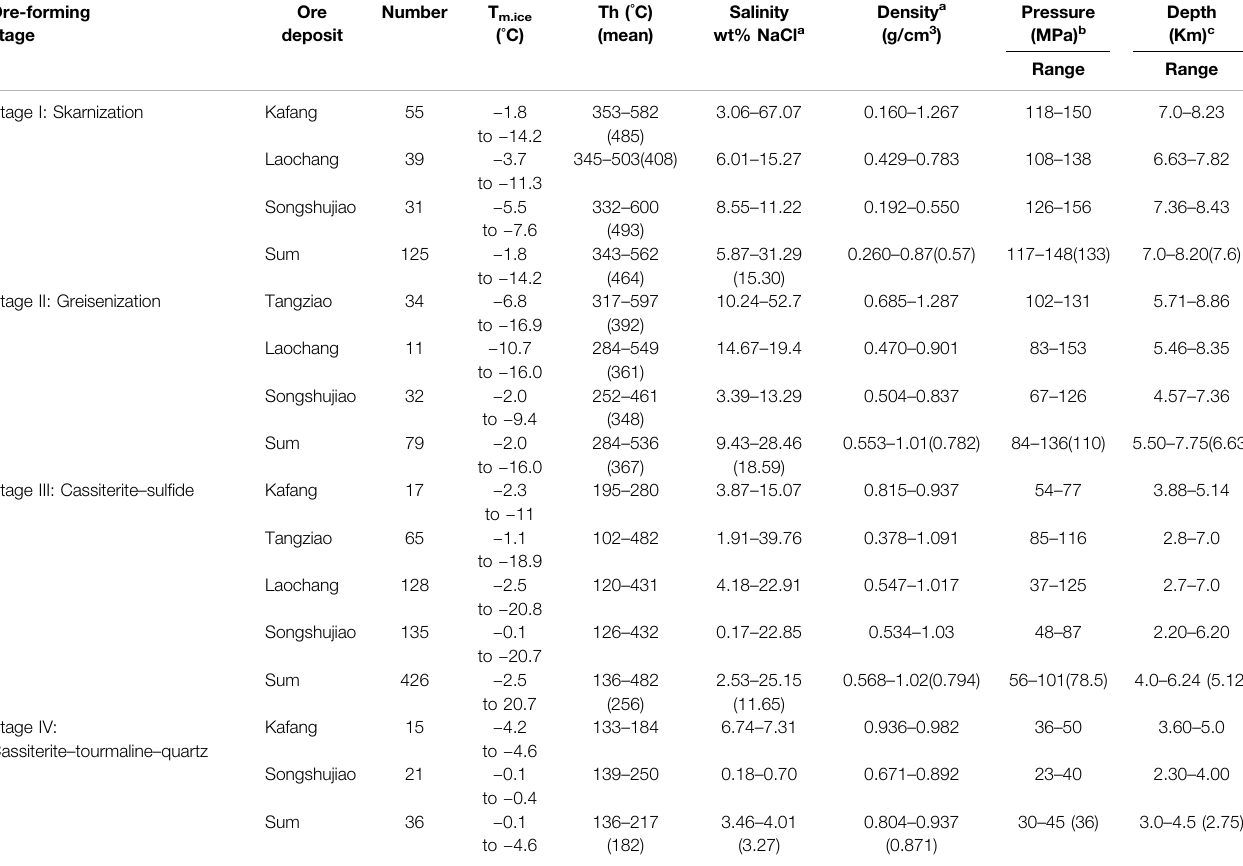
TABLE 1 | Summary of fl uid inclusion data for each stage of the of the Gejiu Sn – Cu polymetallic